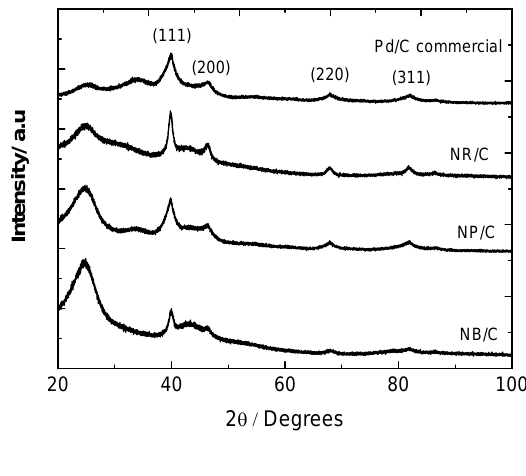
Figure 1. XRD patterns of commercial Pd, NR/C, NB/C and NP/C catalysts.